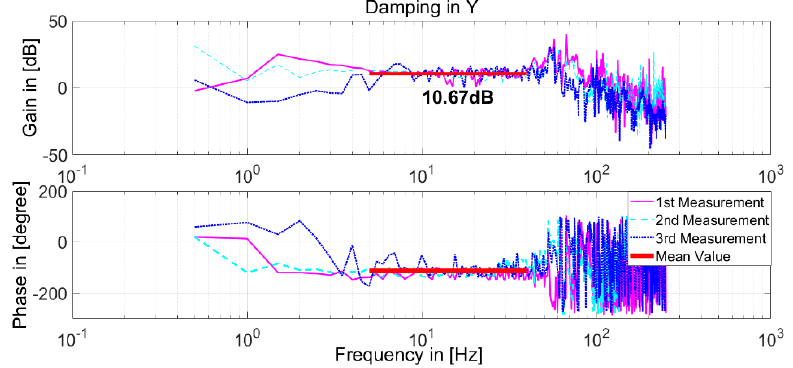
Figure 11. Bode diagram of damping at the relative position [0, 0, 0].